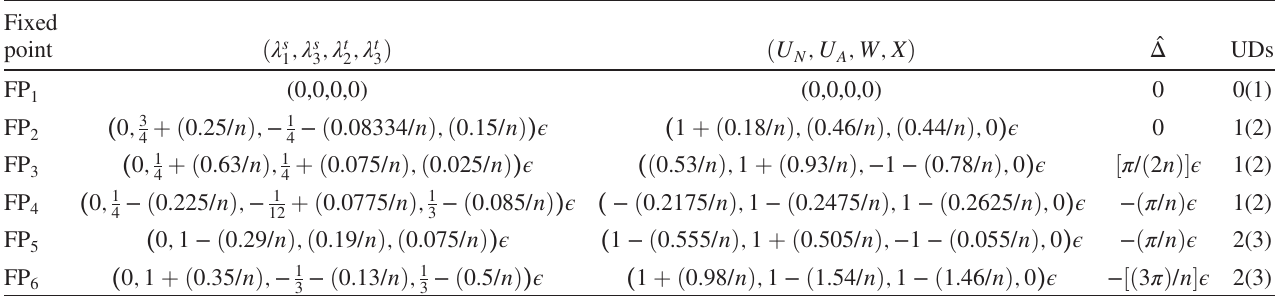
TABLE IV. Location of the six fixed points tabulated in Table III after accounting for 1 / n corrections in Eqs. (30) and (31). The results obtain by utilizing the large- n expansions for f 1 ð n Þ , f 2 ð n Þ , and f 3 ð n Þ [Eq. (26)]. The inclusion of 1 / n corrections does not change the number of fixed points (at least for large enough n ≥ 4 ), but it eliminates the spin-charge separation. Thus, the ϵ expansion, augmented by 1 / n expansion, allows a controlled route to access some strong coupling phenomena (such as the quantum phase transition between the anisotropic semimetal and a broken-symmetry phase) in two spatial dimensions. The coefficients of 1 / n appearing in the locations of the fixed points are extracted numerically. The last column shows the number of unstable directions ˆ Δ (UDs) at a given fixed point in the ¼ 0 hyperplane as well as in the five-dimensional coupling constant space (shown in